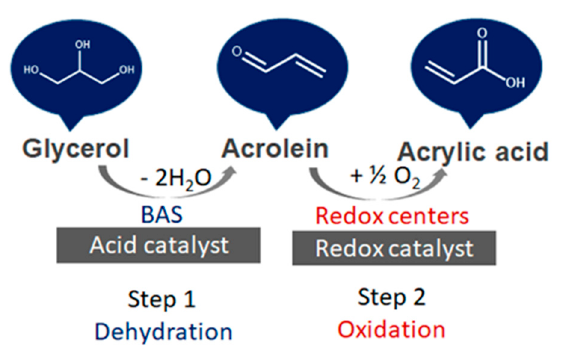
Figure 23. Pathway of the glycerol oxidative dehydration to acrylic acid.